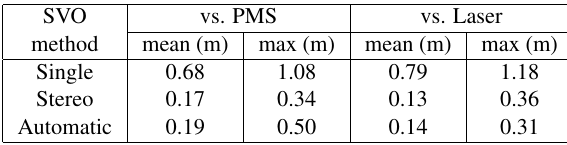
Table 1: Absolute differences between control points